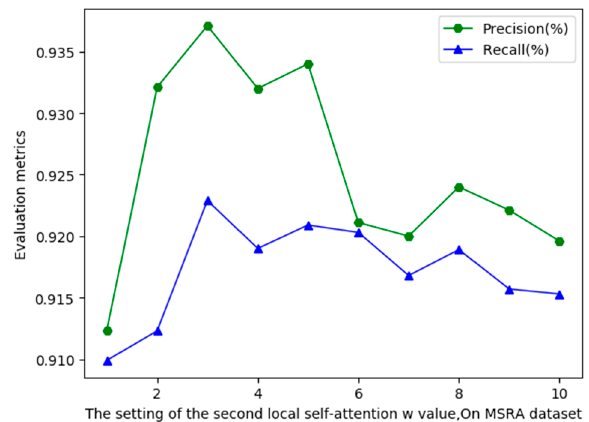
Figure 5. The second local self-attention window setting to 2w + 1, w = 3 can obtain the maximum value. When w > 3, the grasp of information increased, there gradually appears over-fitting, precision, and recall value also begin to decrease.